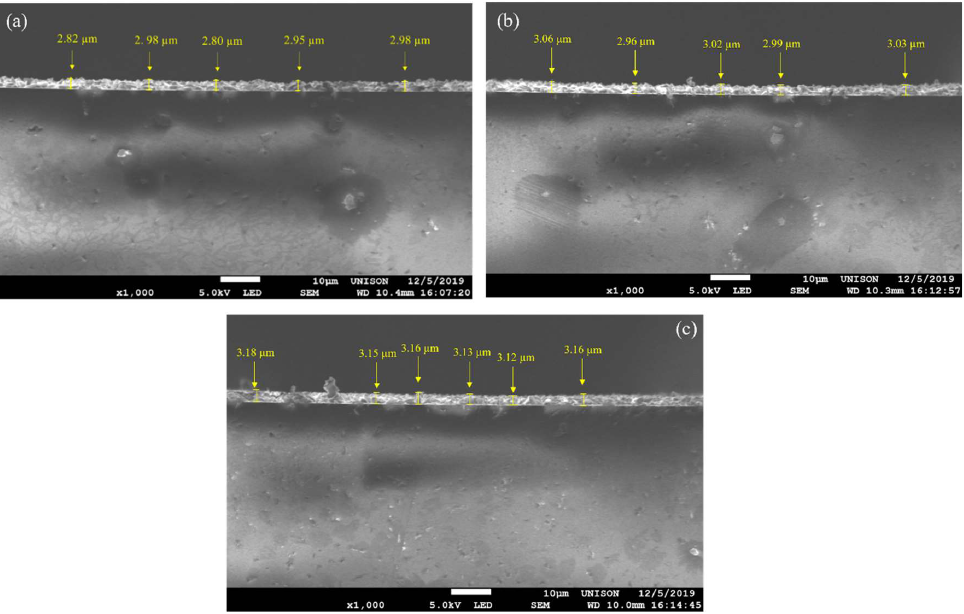
Figure 5. SEM micrographs showing the cross-section of the samples deposited at ( a ) 10, ( b ) 11, and ( c ) 12 h. Figure 6 reveals the EDS analysis of the global area of the micrographs corresponding to the series of samples, showing a relationship of atomic percentages very close to the stoichiometric relationship in the formula of the compound CdCO 3 [25]. Furthermore, there were no considerable impurities in the samples, with silicon coming from the sub- strate and sodium coming from the precursors, both with atomic percentages less than 1.31%. Therefore, the results of the EDS analysis exhibit the successful high-purity syn- thesis of CdCO 3 using the CBD technique at different deposition times. This result sup- ports the feasibility of using CdCO 3 films as a precursor material to produce CdSe, CdTe, and CdO via ion exchange in an aqueous solution or sublimation.